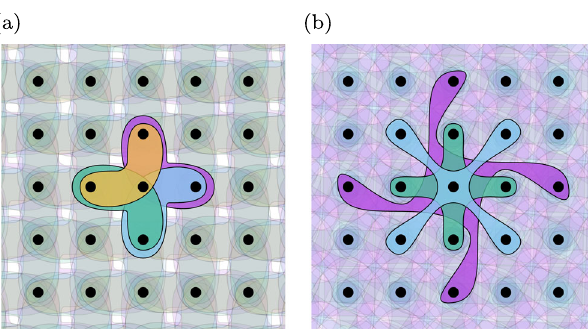
Fig. 10 Example of hypergraphs on a lattice. Two possible hypergraph con fi gurations for lattices with different edge sizes and connectivity, respectively. a k = 3, c = 12 and b k = 5, c = 15. For clarity, a `basis set' of hyperedges is shown for the central node in the foreground (coloured zones). Each node contributes such a basis set to the hypergraph. In the background, with muted colours, all hyperedges are